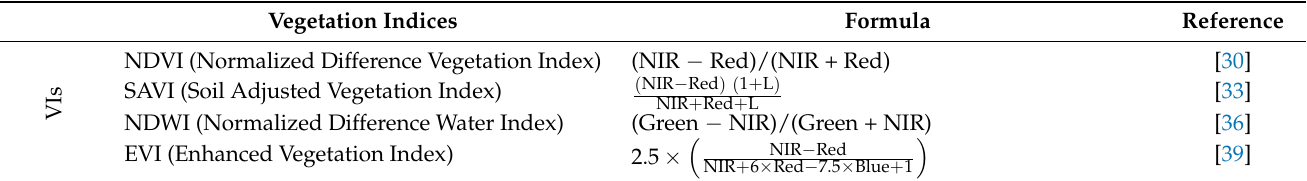
Table 1. The commonly used vegetation indices (VIs) and mangrove-specific indices (MSIs) developed for mangrove mapping. All of the indices have been used on Landsat